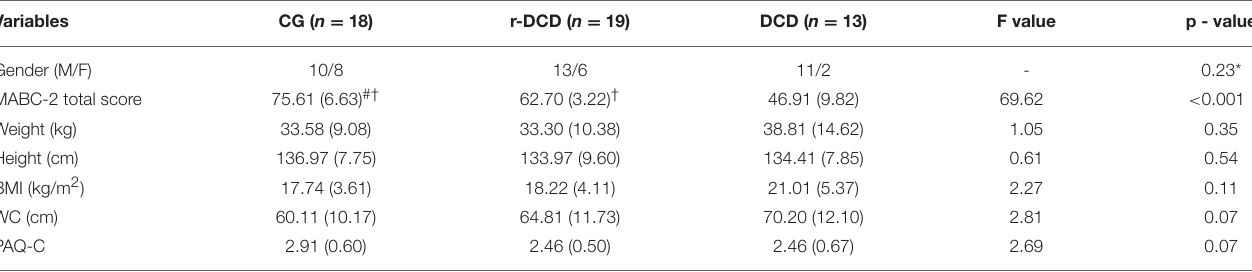
TABLE 1 | Demographic characteristics of children with typical development (CG), children at risk for developmental coordination disorder (r-DCD) and children with DCD.